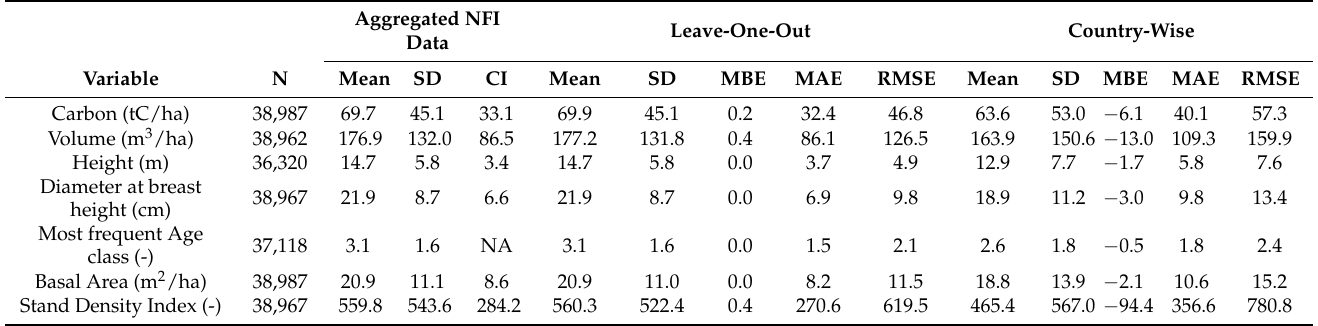
Table 2. Results of the leave-one-out and country-wise cross validation versus gridded NFI data for entire Europe. N is the total number of 8 × 8 km cells evaluated which may differ by variables since tree height and stand age were not reported by all countries. Aggregated NFI data refers to the aggregated National Forest Inventory (NFI) plots, for which the mean value, standard deviation (SD) and confidence interval (CI) are shown. For leave-one-out and country-wise cross validation the mean value, SD, mean bias error (MBE), mean absolute error (MAE) and root mean squared error (RMSE) are shown. Not Available (NA) indicate that this metric cannot be calculated.